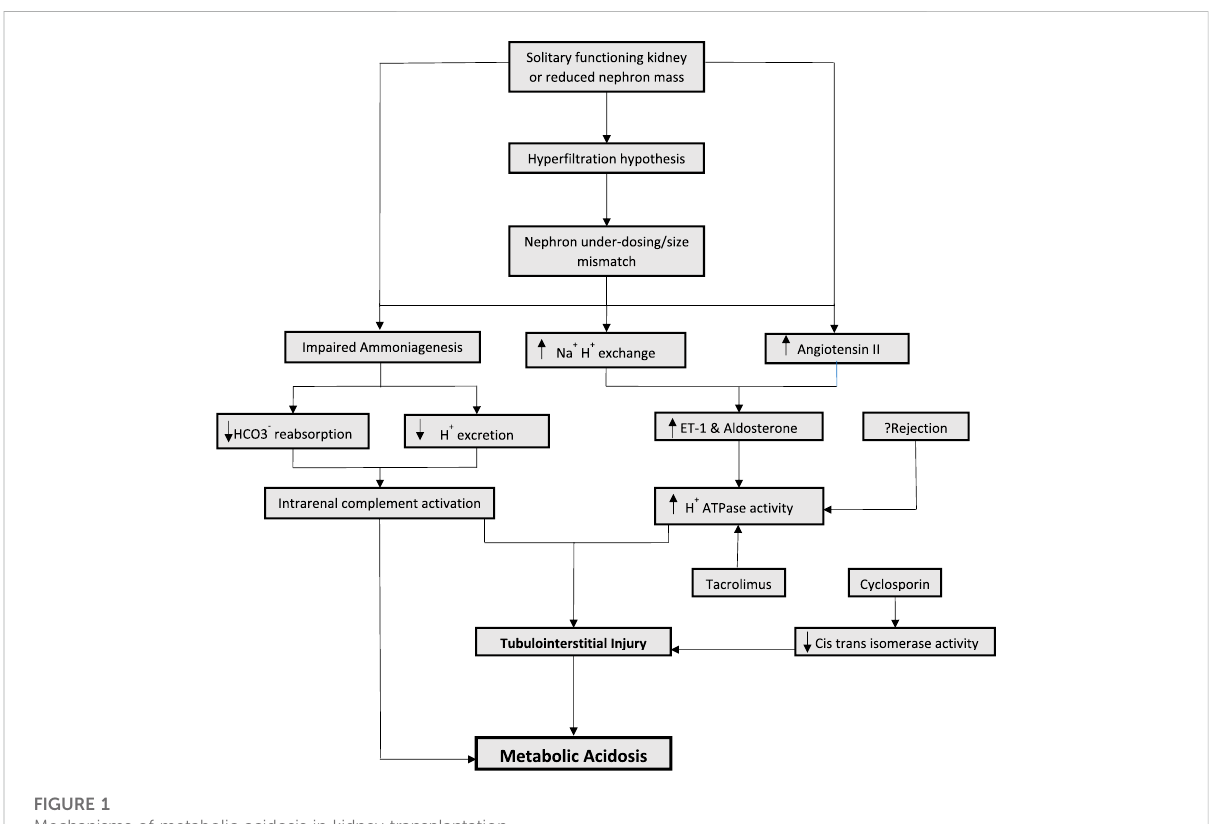
FIGURE 1 Mechanisms of metabolic acidosis in kidney